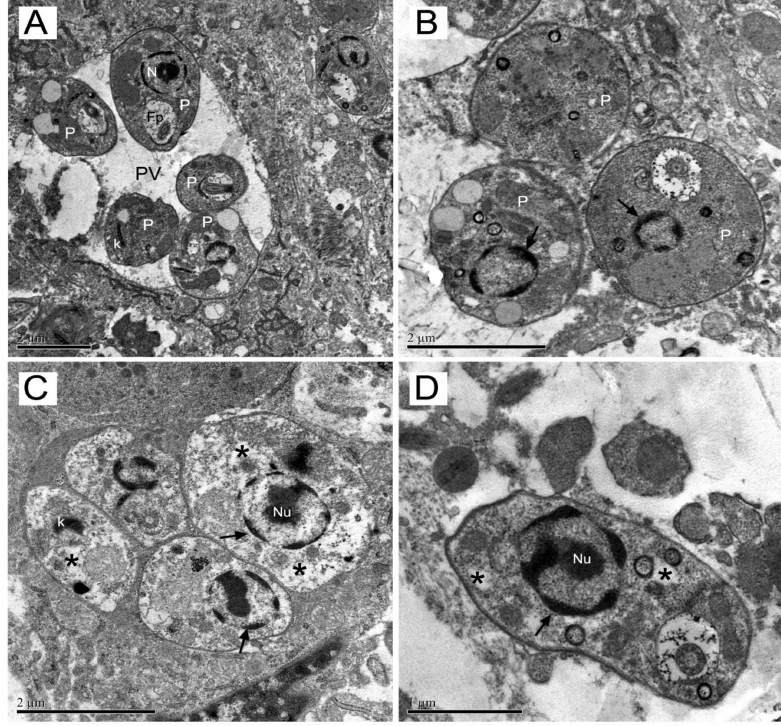
Figure 5. Transmission electron microscopy of mice skin lesion. The ultrastructural analysis of amastigotes from lesion were performed in untreated ( A ) or mice treated with meglumine antimoniate or Epoxymethoxy-lawsone at higher doses (22.7 mg of Sb(V)/kg/day and 11.4 mg/kg/day, respectively). In ( A ): amastigotes with no morphological changes within parasitophorous vacuoles (PV); bar-shaped kinetoplast (K); nuclei (N) and flagellar pocket (Fp). In ( B ): Amastigotes (P) show dense nuclear chromatin (thin arrow) with altered profile and absence of nucleoli ( → ). In ( C ): Amastigotes (P) with rarefied cytoplasm (*); kinetoplast with an atypical condensation (k) and dense nuclear chromatin ( → ) and nucleolus (Nu). In ( D ): Amastigote (P) shows dense nuclear chromatin with altered profile and absence of nucleoli. The images are representatives of ten selections of each group